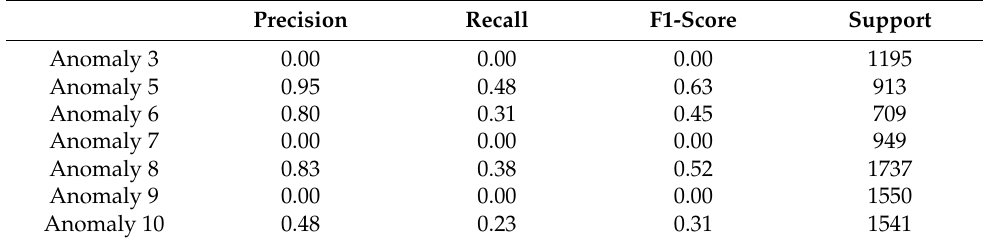
Table 6. Classification report of the level 1 and 2 anomalies.